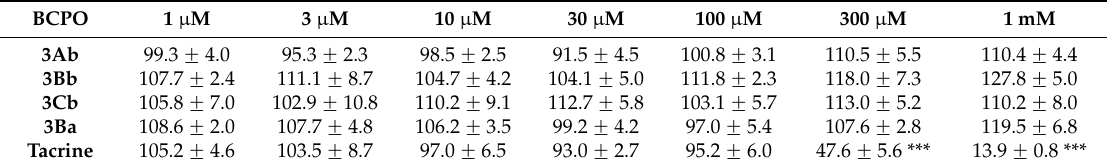
Means ± SEM of triplicates from at least three different cultures. *** p < 0.001, as compared to the control cultures (one-way ANOVA).